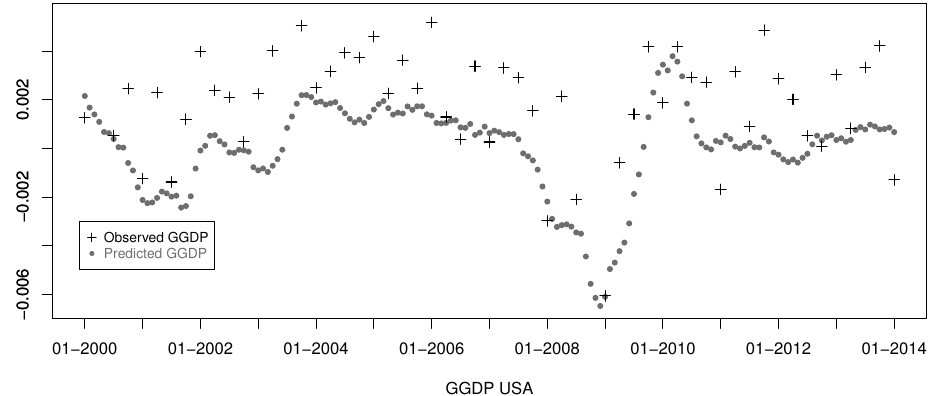
Figure 2. Observed quarterly (grey pluses) and estimated monthly (black dotes) US